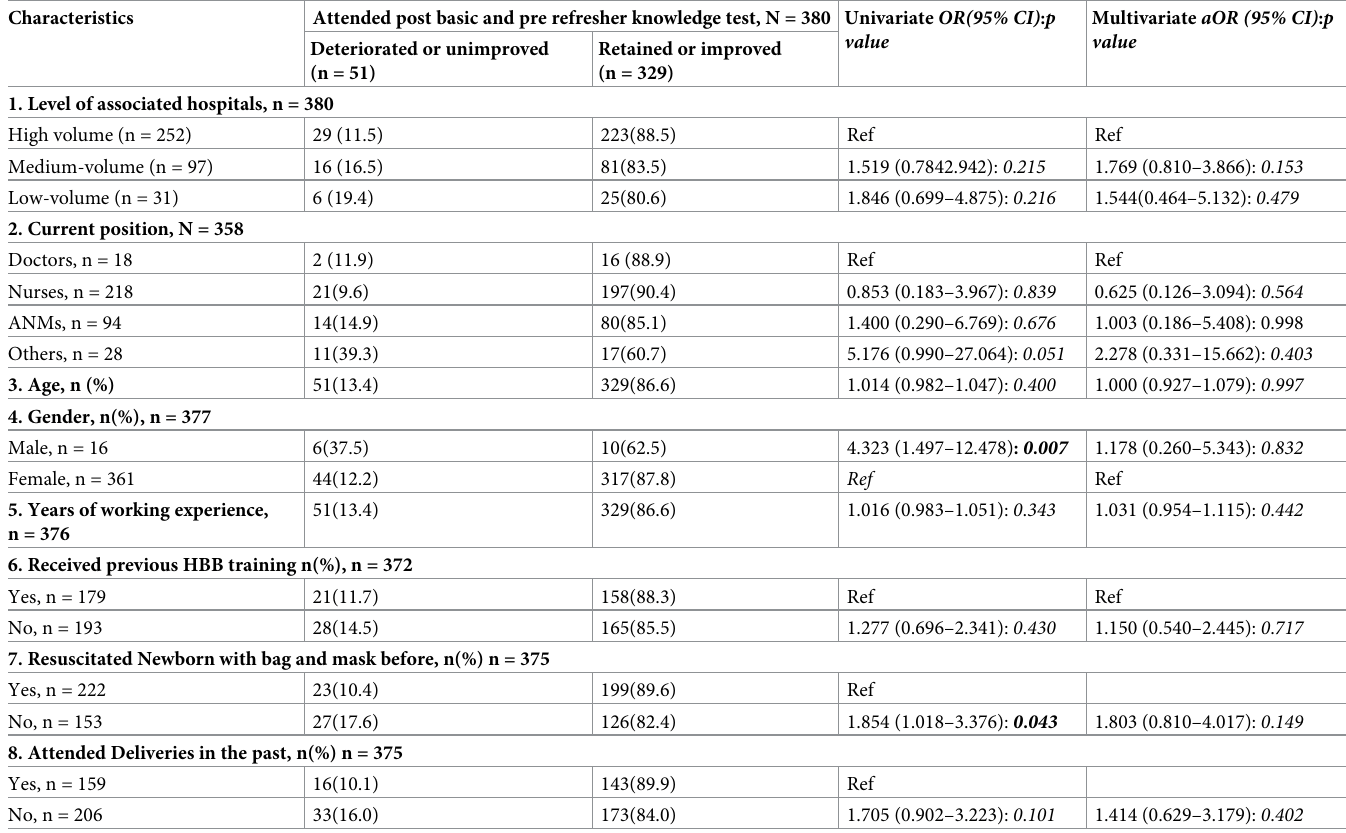
Table 4. Factors associated with deterioration of knowledge (post-basic vs pre-refresher).